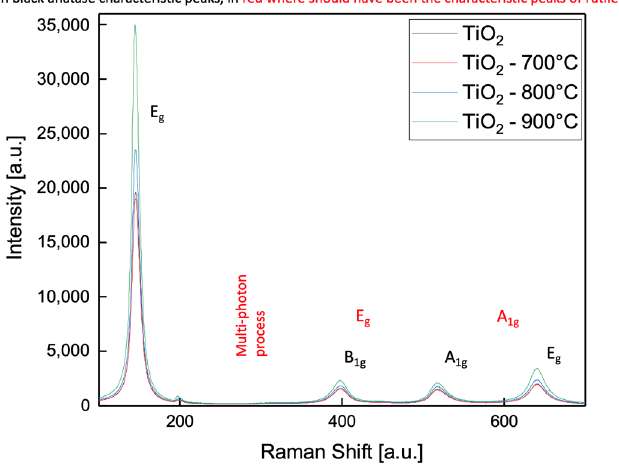
Figure 2. Raman spectra of commercial TiO 2 annealed at different temperatures.